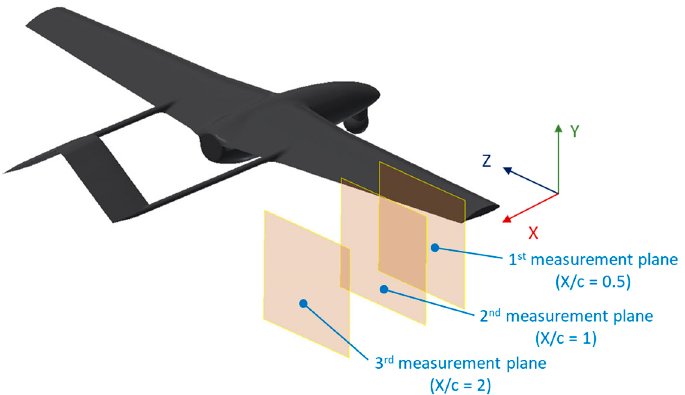
Figure 5. Measurement planes for the Laser Doppler Anemometry (LDA) measurements around the Hellenic Civil Unmanned Air Vehicle (HCUAV) model.